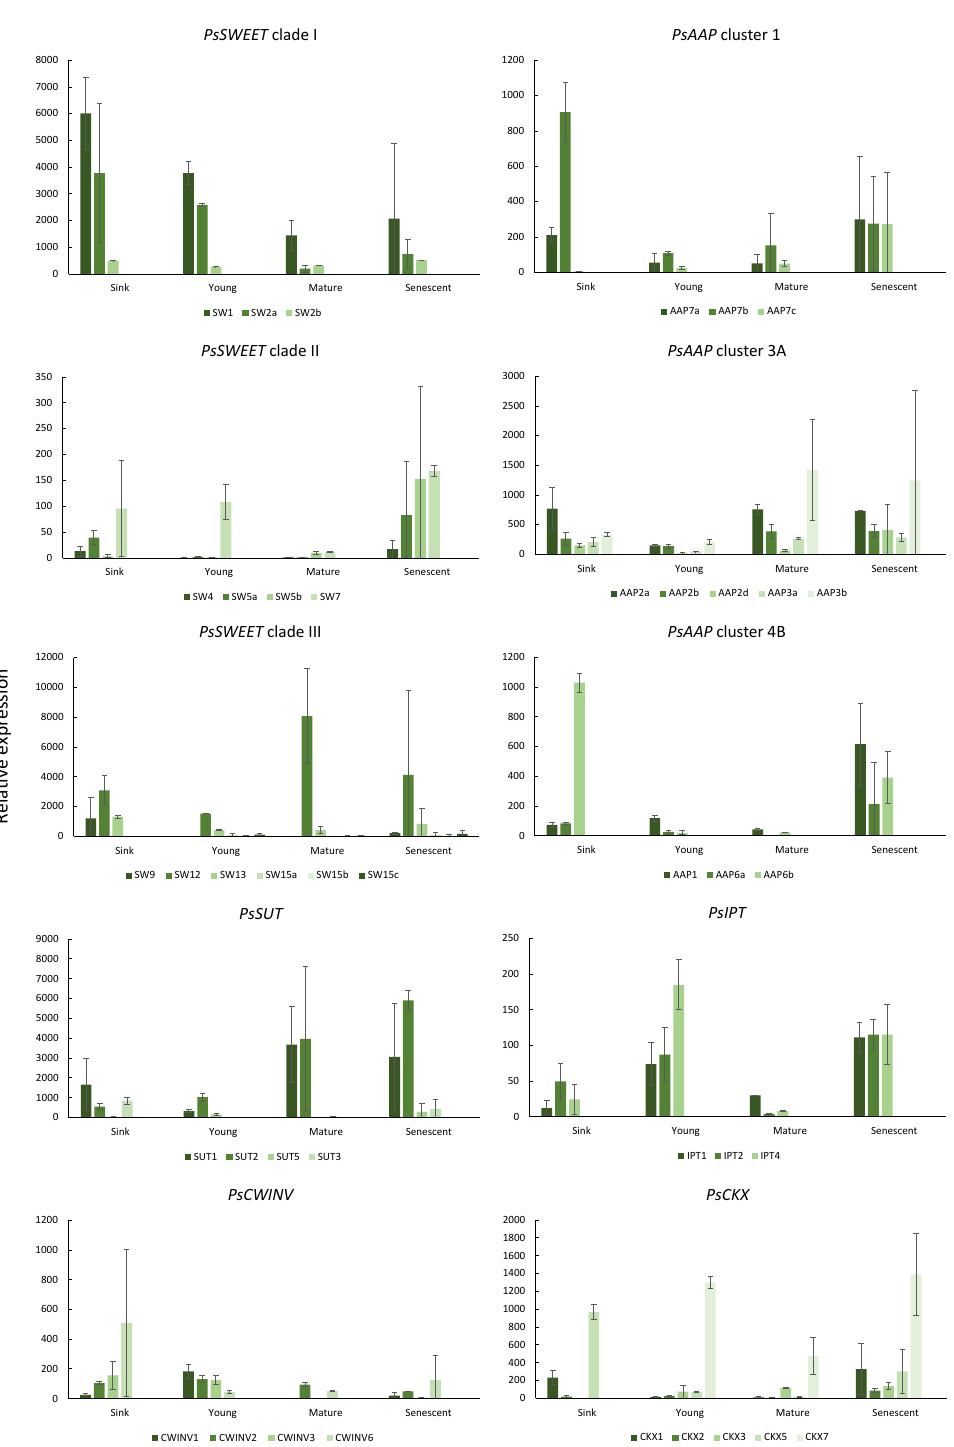
Figure 2. Relative expression of Sugar Will Eventually be Exported Transporter ( SWEET ), sucrose transporter ( SUT ), amino acid permease ( AAP ) transporter gene families, cell wall invertase ( CWINV ), cytokinin biosynthesis ( IPT ), and cytokinin degradation ( CKX ) gene families in leaves of Pisum sativum of different ages (sink: expanding sink leaves; young: source leaves subtending pods five days after flowering; mature: source leaves subtending pods 20 days after flowering; senescent: senescing leaves). Mean fold-change values (y-axis) were calculated using PsEF , PsGAP , and PsACT as internal controls. The results are expressed as the average of two biological replicates, with three technical replicates for each. Results are ±